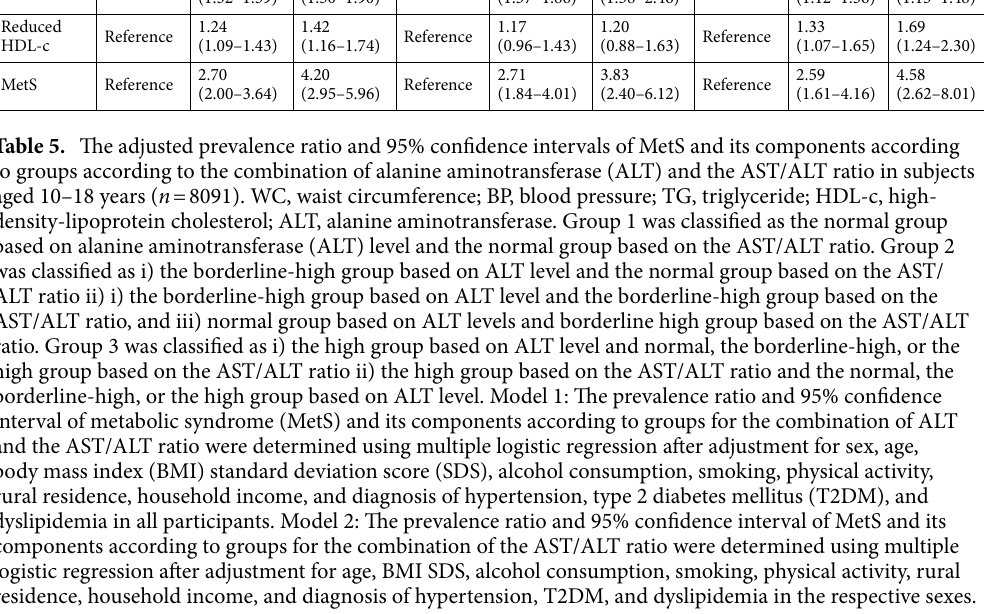
LMS methods using the 2017 Korean reference 36 . Blood samples were collected after the participants fasted for at least 8 h. Samples were immediately centrifuged, transported to a central laboratory (NeoDin Medical Institute, Seoul, Korea) and analyzed within 24 h. Serum levels of total cholesterol (T-C), high-density lipoprotein choles- terol (HDL-c), TG, and glucose were measured enzymatically using a Hitachi 7600 automatic analyzer (Hitachi, Tokyo, Japan). LDL-c was calculated with Friedewald’s equation 35 . Collection of lifestyle parameters and socioeconomic status. Lifestyle-related parameters and socioeconomic information were collected by questionnaires. Smoking was defined as having smoked more than five packs of cigarettes throughout one’s lifetime. Alcohol consumption was defined as at least two alcoholic bev- erages/month during the previous year. Physical activity was defined as: (1) intense physical activity for 30 min at least three days/week, (2) moderate physical activity for 30 min at least five days/week, or (3) walking for 30 min at least five days/week. Based on physical activity, subjects were classified as exercising or non-exercising. For socioeconomic information, household income was categorized as being within the lowest quartile or not. The residence area was divided into urban and rural areas. Definitions of MetS and its components. Obesity and overweight were defined as ≥ 95th and ≥ 85th but < 95th percentile, respectively, as shown in a previous study 36 . The definition of MetS followed the modified criteria of the National Cholesterol Education Program Adult Treatment Panel III (NCEP-ATP III), as previously described in our published paper 26 ; subjects who met 3 of the following 5 criteria were defined as having MetS: (1) increased WC based on the Korean pediatric population; ≥ 90th percentile for age and sex according to the 2017 Korean growth chart 36 ; (2) elevated BP, namely, SBP or DBP ≥ 90th percentile for age- and sex-matched reference data from the Korean pediatric population 36 or treatment with antihypertensive medication; (3) fast- ing blood glucose ≥ 100 mg/dL or treatment for type 2 diabetes mellitus (T2DM); (4) elevated TG (≥ 110 mg/ dL); and (5) low HDL-c (< 40 mg/dL). T2DM was diagnosed satisfying one or more of the following criteria: (1) subjects who self-reported their disease using a questionnaire, (2) current medication or insulin use to manage T2DM, or (3) subjects with a fasting glucose level ≥ 126 mg/dL during the survey period. Statistical analysis. The basic characteristics consisted of continuous variables and categorical variables; each variable is presented as the mean ± standard deviation (SD) and frequencies or percentages (%), respec-